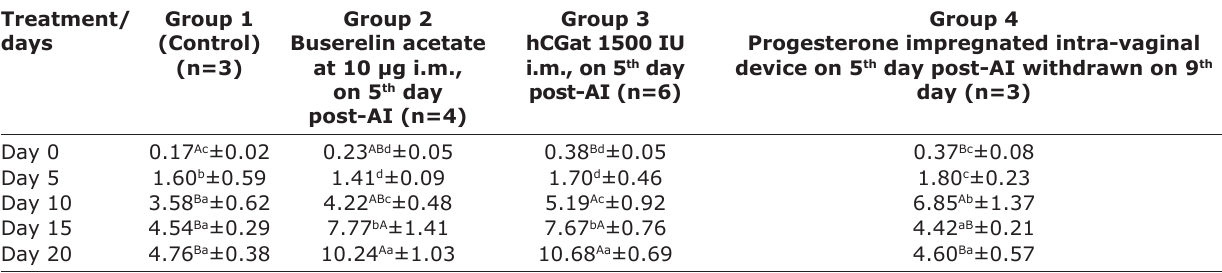
Table-1: Comparison of mean plasma progesterone values of pregnant animals of different groups on different days of the estrous cycle. Treatment/